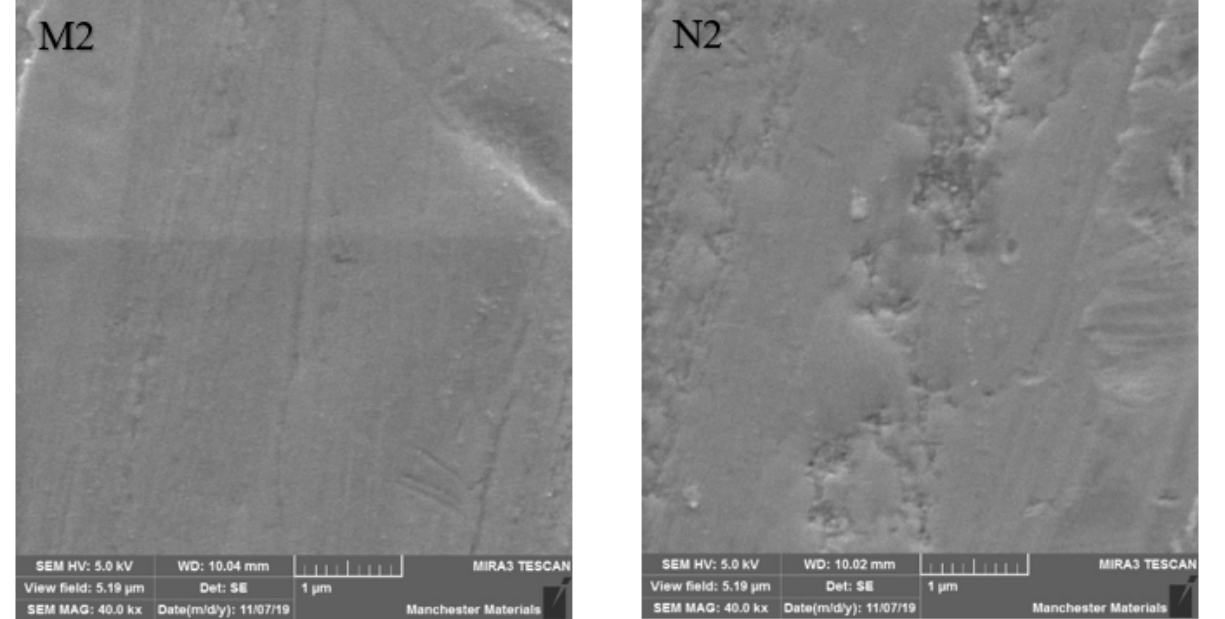
Figure 8. SEM imaging at 40 kx magnification at a point away from impact. Note smoother M2 surface compared to N2.